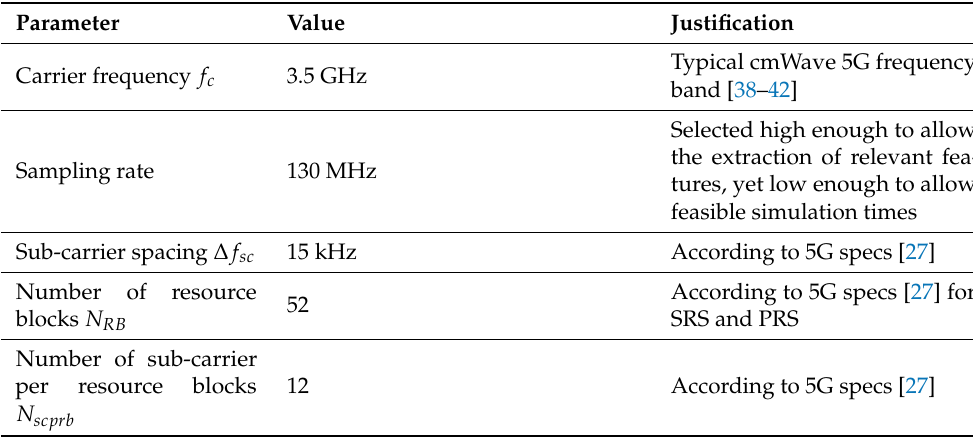
Table 3. Simulation